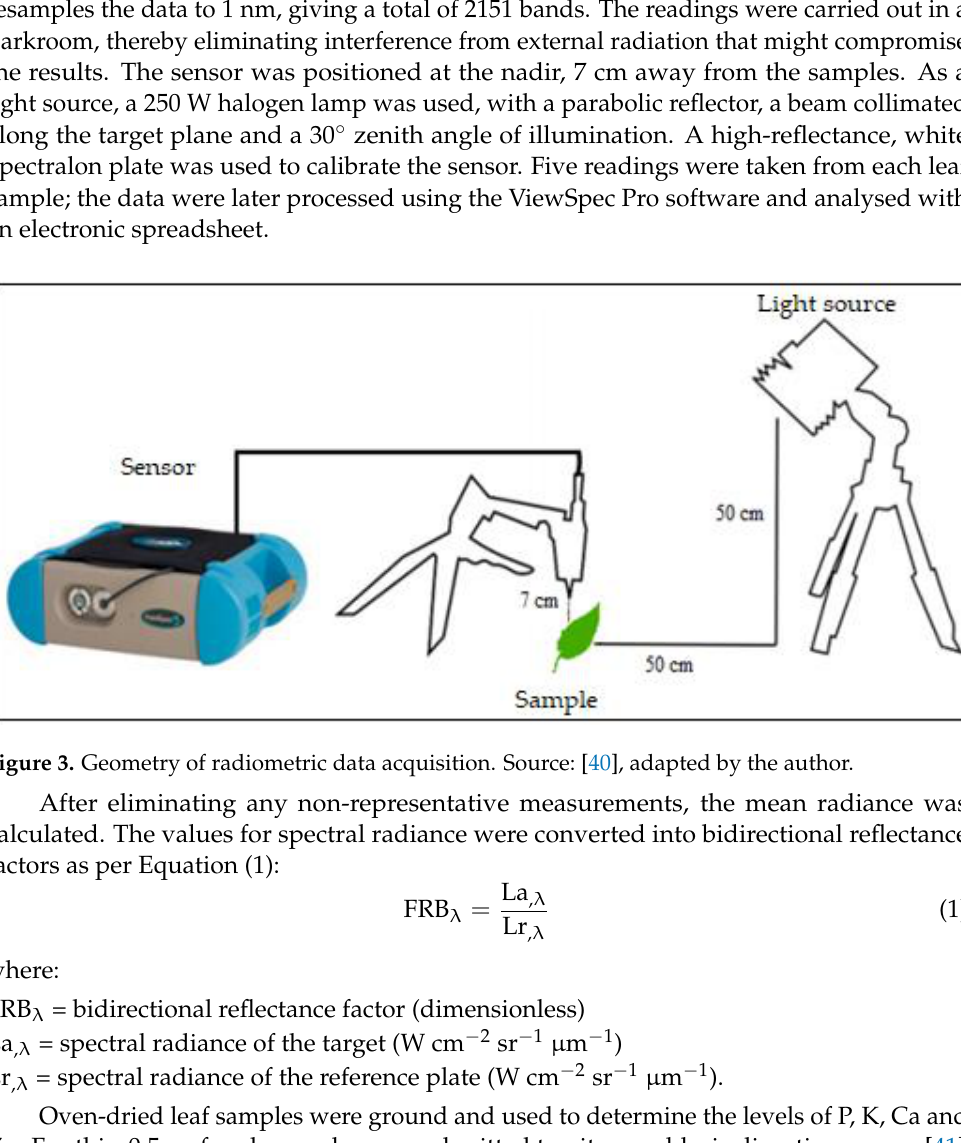
where: where: FRB λ = bidirectional reflectance factor